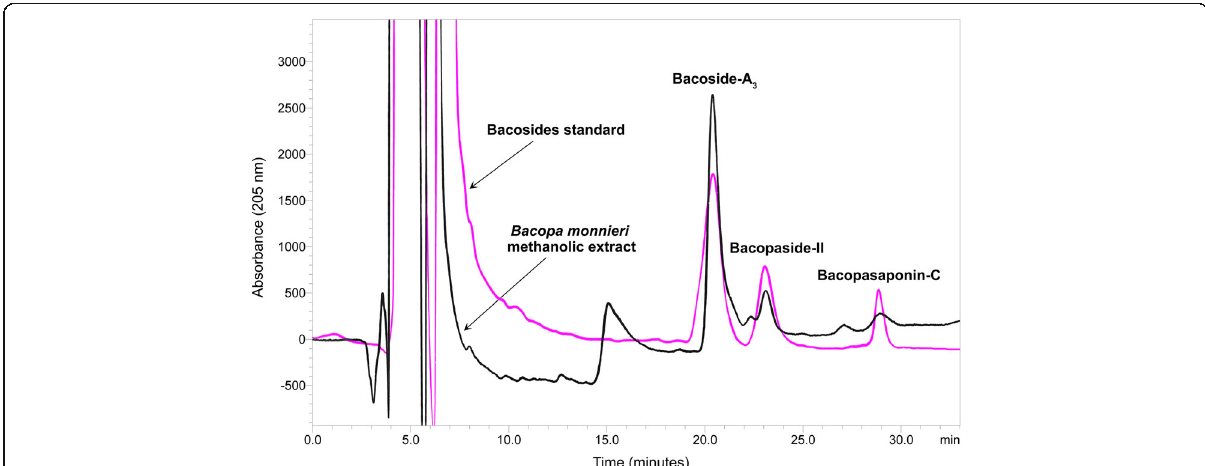
Fig. 1 HPLC-UV fingerprint of bacoside “ A ” major components (bacoside-A 3 , bacopaside-II and bacopasaponin-C) quantified in Bacopa monnieri methanolic extract overlaid with that of standard